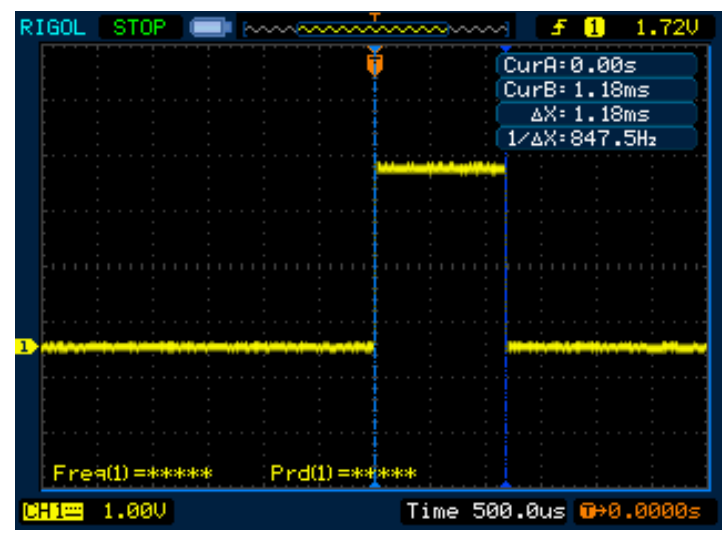
Figure 6. 2D orientation estimation Kalman filter processing